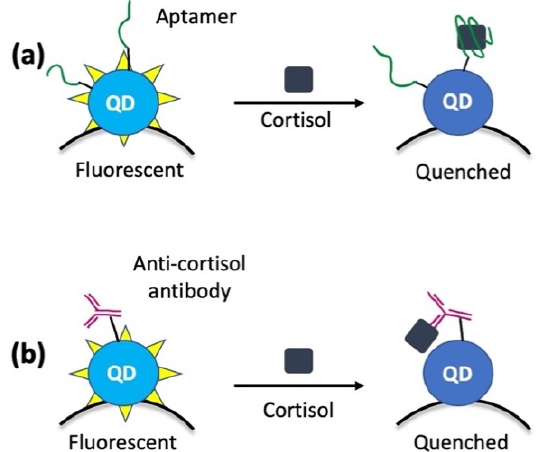
Figure 3. Target-induced quenching for cortisol detection; efficiency is modulated by the amount of cortisol captured on each quantum dot: ( a ) quantum dots conjugated with aptamers and ( b ) quantum dots conjugated with antibodies and transported by a magnetic nanoparticle (MNP).